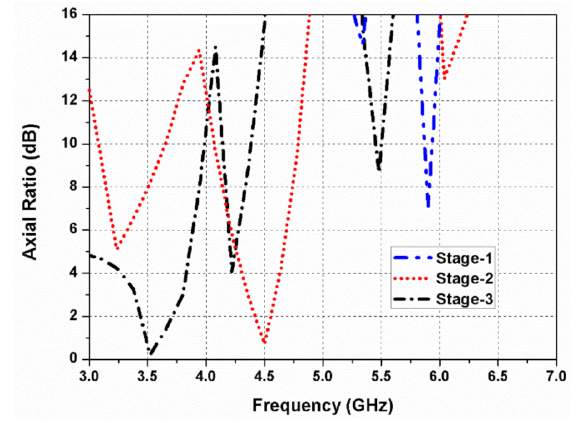
Figure 4. Simulated axial ratio of the evolution